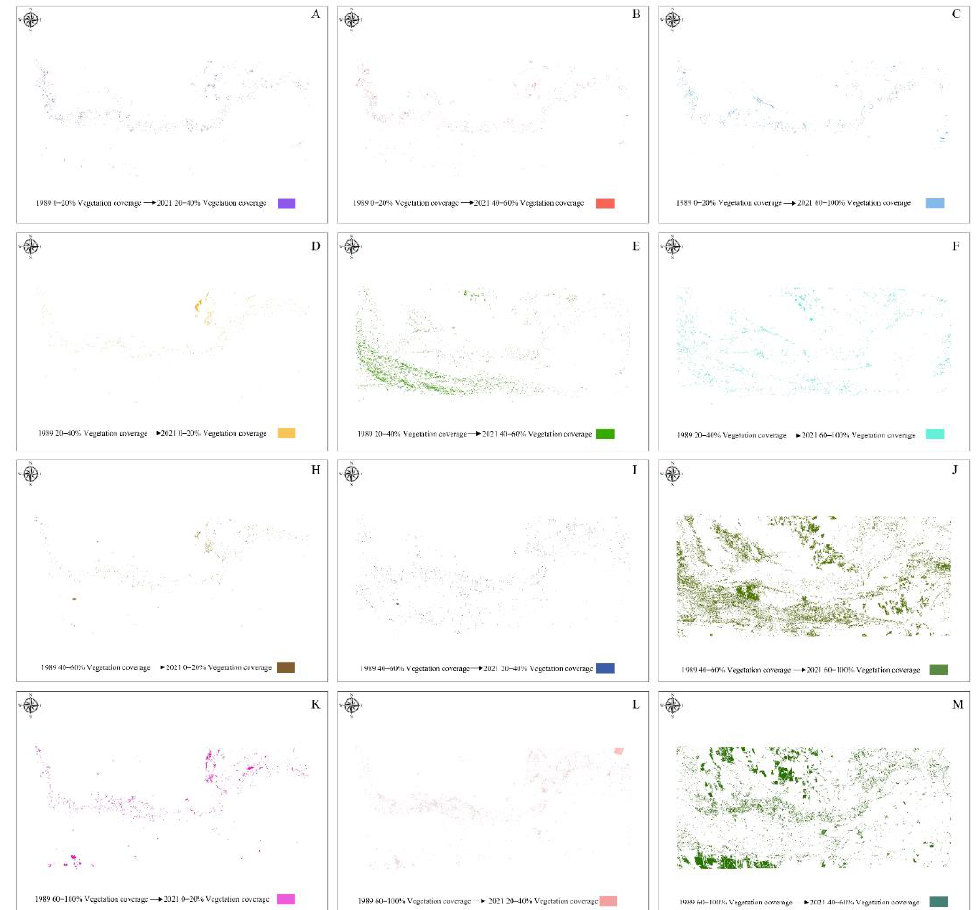
Figure 10. Changes in different vegetation coverage intervals in the past 30 years from 1989